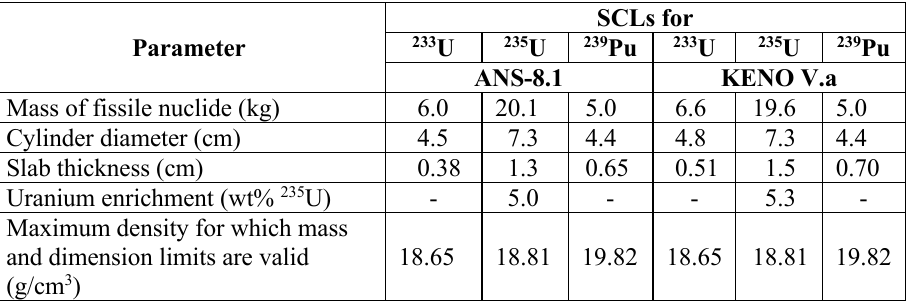
Table III. Single-parameter limits for metal units.